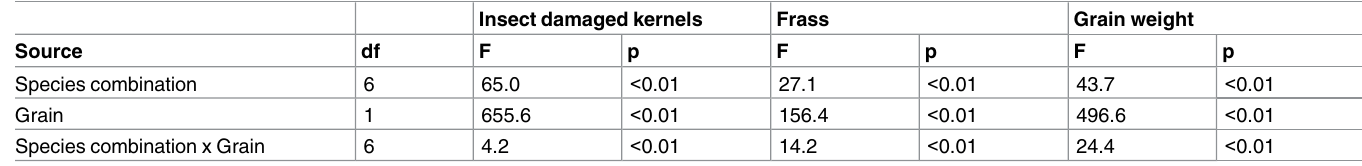
Table 3. ANOVA parameters for insect damaged kernels on vials with different species combination and different